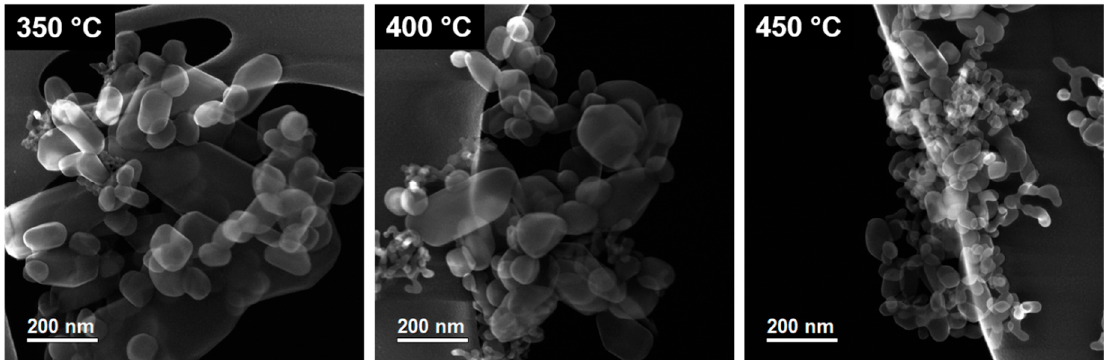
Figure 2. SE images of GdScO 3 produced at 350, 400, and 450 °C. GdScO 3 grown at lower temperatures had a less negative Δ G rxn and consequentially had more faceting and were larger than particles grown at higher temperatures (see later discussion). Note that SE images do not show the surfaces of GdScO 3 as clearly as other oxides do, as discussed in the text.